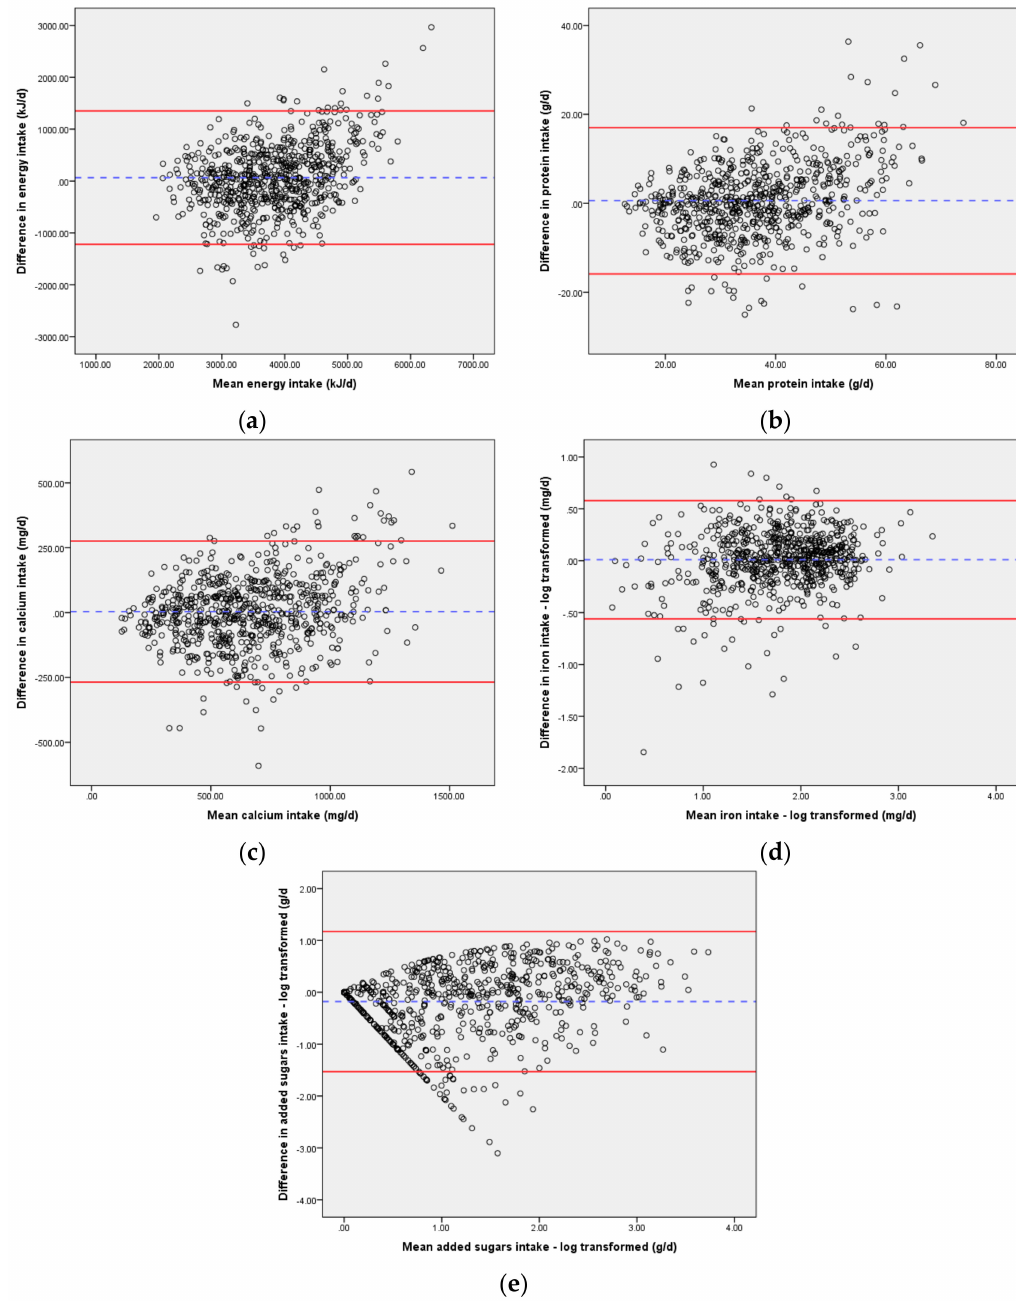
Figure 1. Bland–Altman plots of agreement between dietary intakes reported in the 24HR and 24HR + 2DFR in Australian toddlers aged 12 months ( n = 699): ( a ) Energy intake; ( b ) Protein intake; ( c ) Calcium intake; ( d ) Iron intake; ( e ) Added sugars intake. Difference in intake for each plot ( y -axis) is 24HR − (24HR + 2DFR). The plots show the mean difference (—) and the limits of agreement (—) for each nutrient. kJ/d: kJ/day; g/d: g/day; mg/d: mg/day. When ranking participants according to their intake using weighted Kappa statistic, acceptable agreement beyond chance was found between the 24HR and the 24HR + 2DFR for energy, protein, calcium, and added sugars, with good agreement for iron [10] (Table